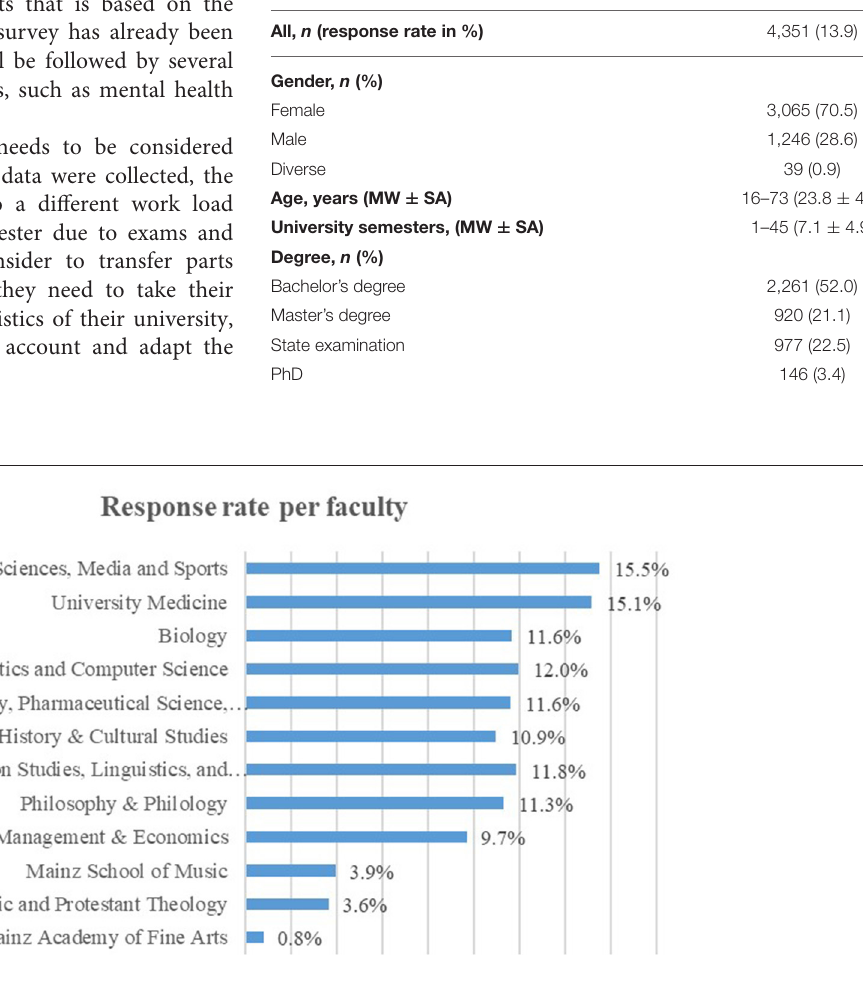
Frontiers in Public Health |